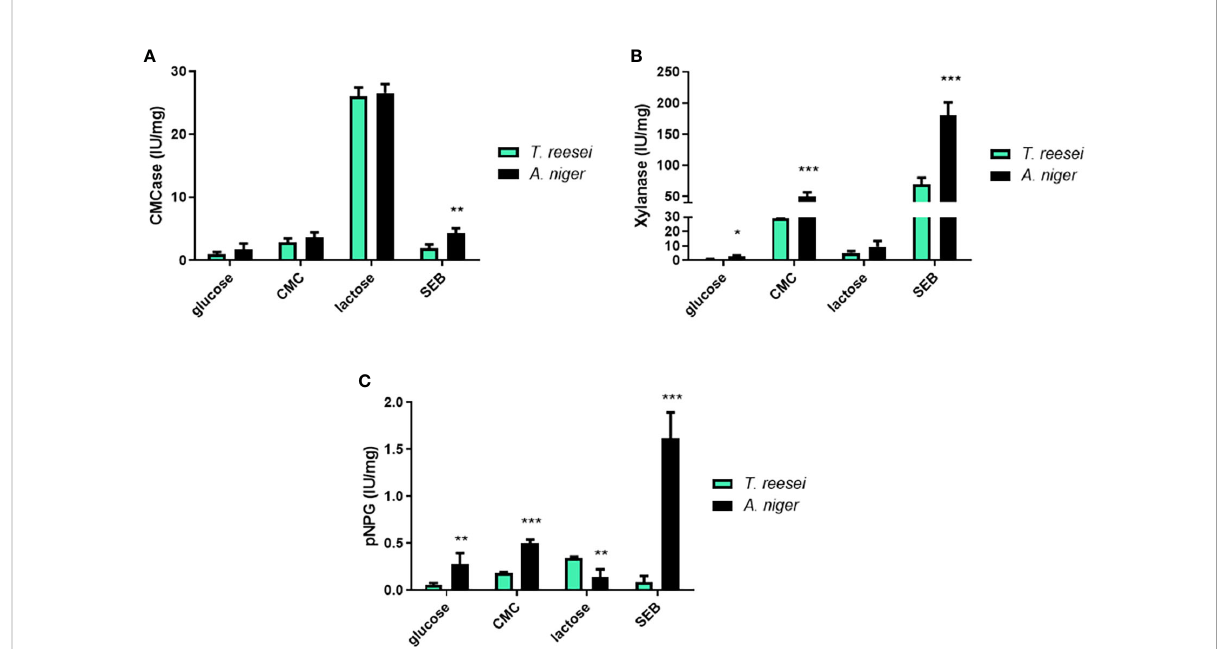
FIGURE 8 Enzymatic activities for T. reesei and A. niger grown on glucose, CMC, lactose, and SEB. CMCase (A) , xylanase (B) , and pNPGase (C) activities were normalized by the amount of total secreted protein. The statistical difference between both fungi for the same condition was determined by the two-tailed unpaired Student t-test. *P-value < 0.05; ** <0.01; ***